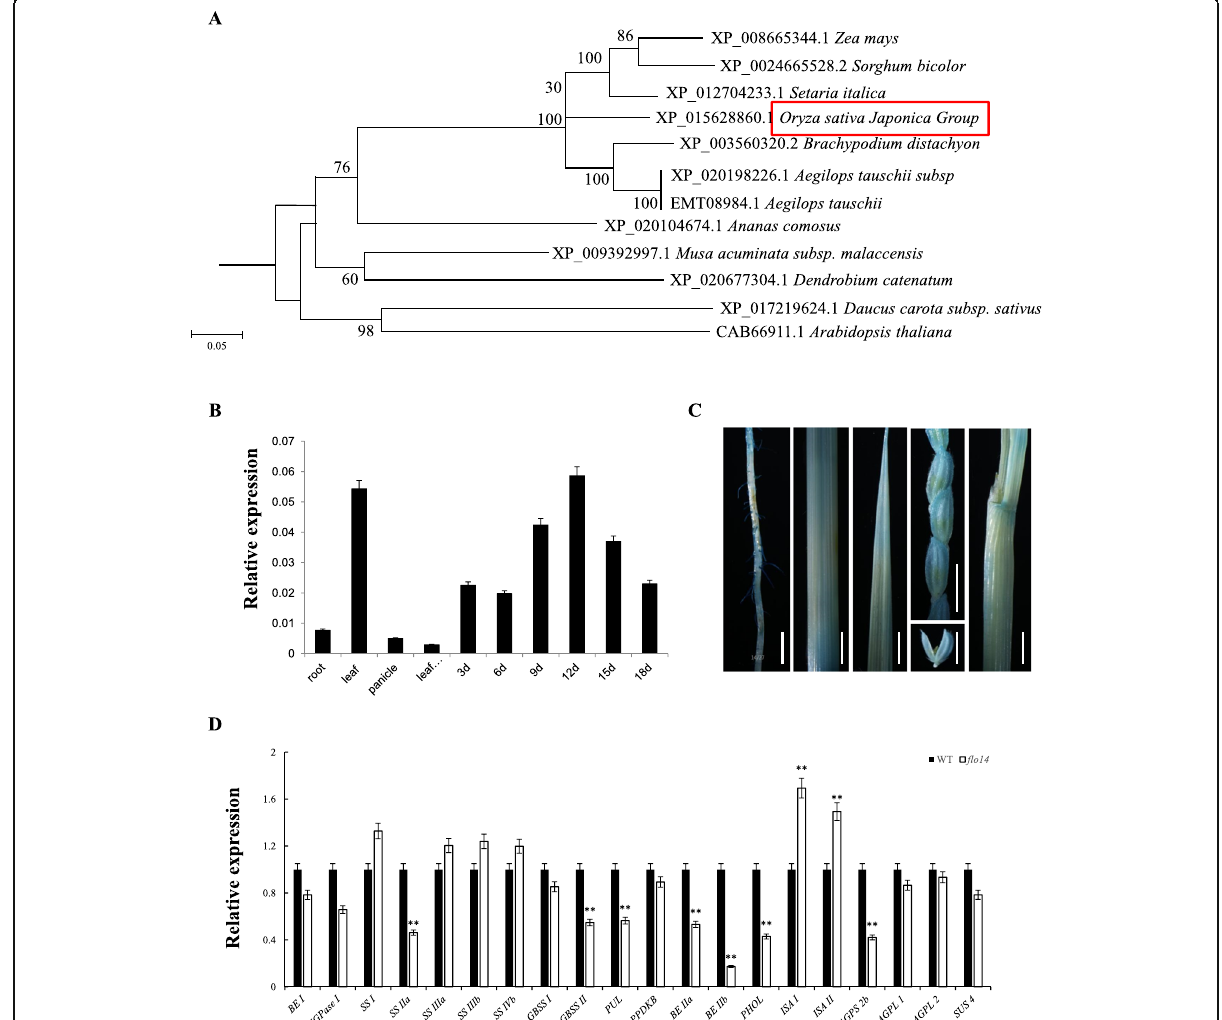
frame. b Expression levels of PPR gene in various tissues and different developmental stages endosperm of the wild type ( n =3 each). c Histochemical staining showed that PPR: GUS reporter gene is ubiquitously expressed in the root, stem, leaves, panicles and leaf shoots from the left photo to the right, respectively. d Real-time PCR analysis of starch synthesis genes in 12days after flowering (DAF) wild-type (WT) and flo14 mutant ( flo14 ) seeds. Actin1 was used as an internal control. Data gives as means ± SD from three independent biological replicates and was compared by Student ’ s t -test (* P <0.05, ** P <0.01). Scale bars: 1cm for all panels in ( c ). BE I: branching enzyme I, UGPase I: UTP-glucose-1-phosphate-uridyly-1 transferase, SS I:soluble starch synthase I, SS IIa: soluble starch synthase